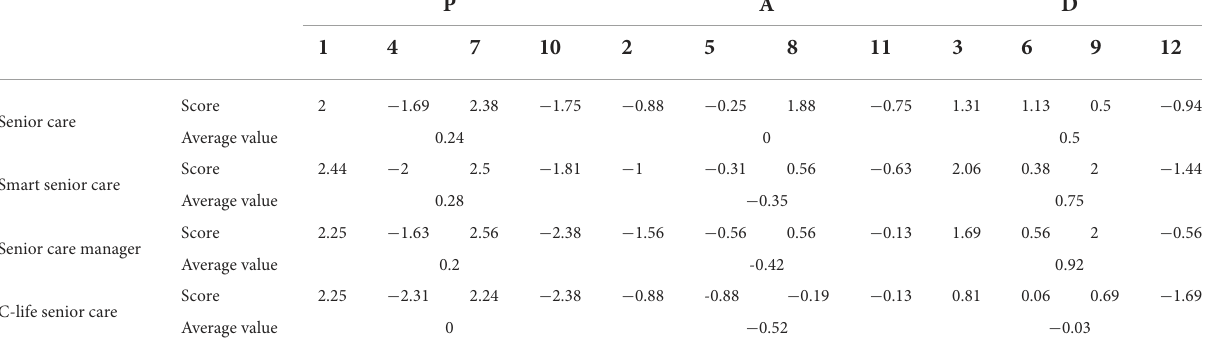
TABLE 3 Correspondence of each item and each